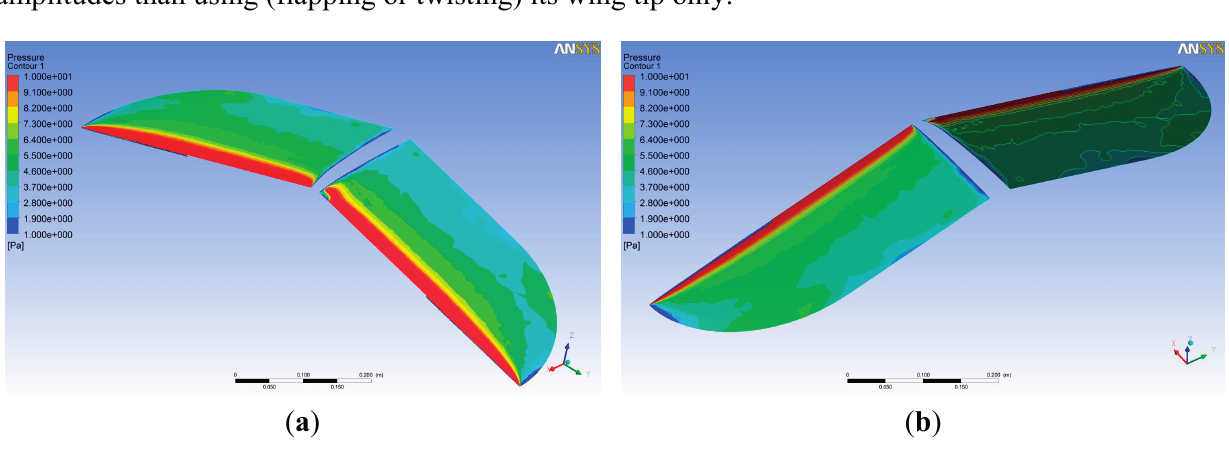
Figure 13. Surface pressure on the albatross wing at dihedral angle = − 15°, upper surface ( a ) and lower surface ( b